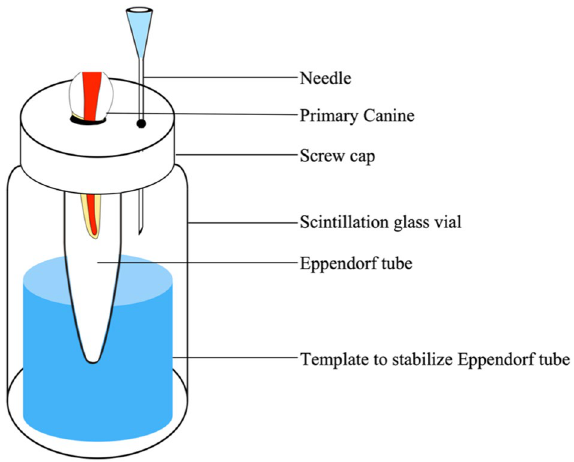
Figure 1. Schematic presentation of the apparatus used to obtain apically extruded